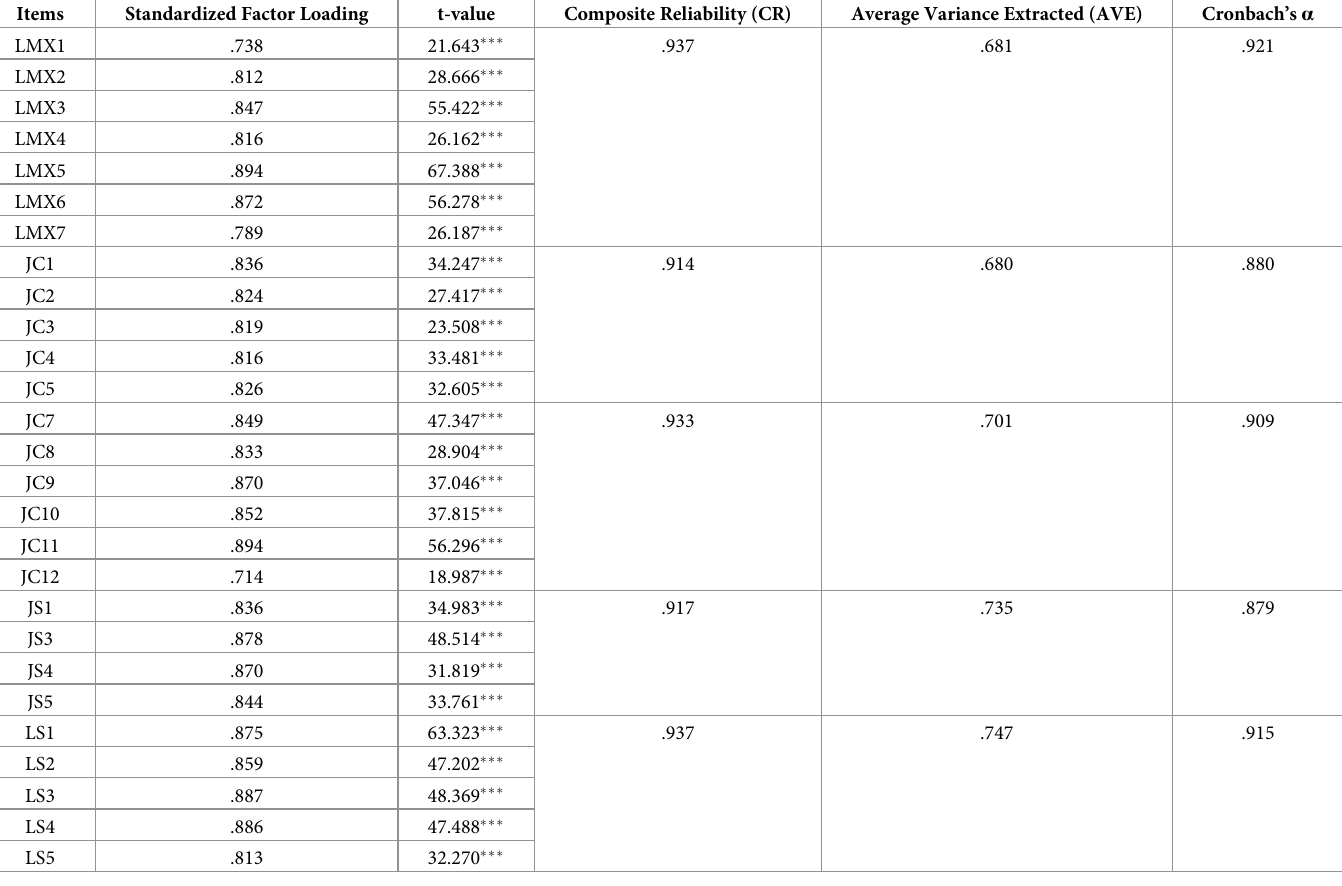
Table 1. Standardized factor loading, construct reliability and convergent